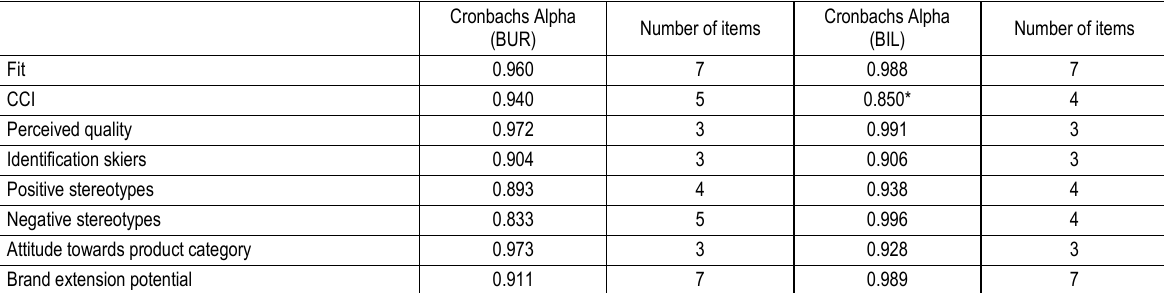
Table 1. Reliability statistics of the individual constructs